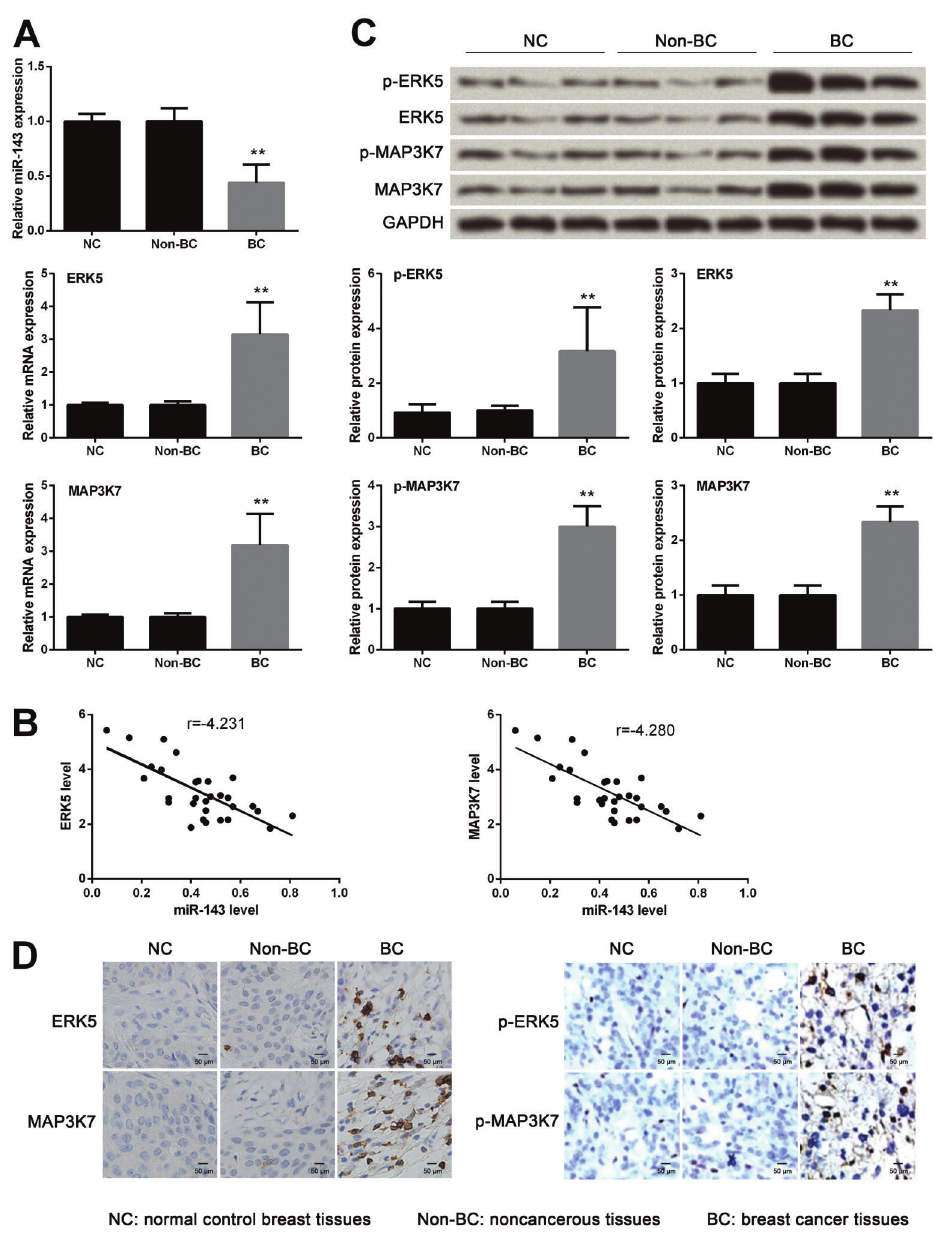
Figure 1. A , mRNA levels of miR-143, ERK5 and MAP3K7 in breast cancer (BC) tissues, noncancerous tissues and normal control (NC) breast tissues using RT-qPCR. B , Correlation of miR-143 with ERK5 and MAP3K7 mRNA levels in BC tissues by Pearson correlation analysis. C , Expression and phosphorylation levels of ERK5 and MAP3K7 in BC tissues, noncancerous tissues and NC breast tissues by western blotting. D , Expression and phosphorylation of ERK5 and MAP3K7 by immunohistochemistry. ERK5: extracellular signal- regulated kinase 5; MAP3K7: mitogen-activated protein 3 kinase 7. Data are reported as means ± SD of 30 samples. Each analysis was repeated three times. **P o 0.01 compared with noncancerous tissues or NC breast tissues